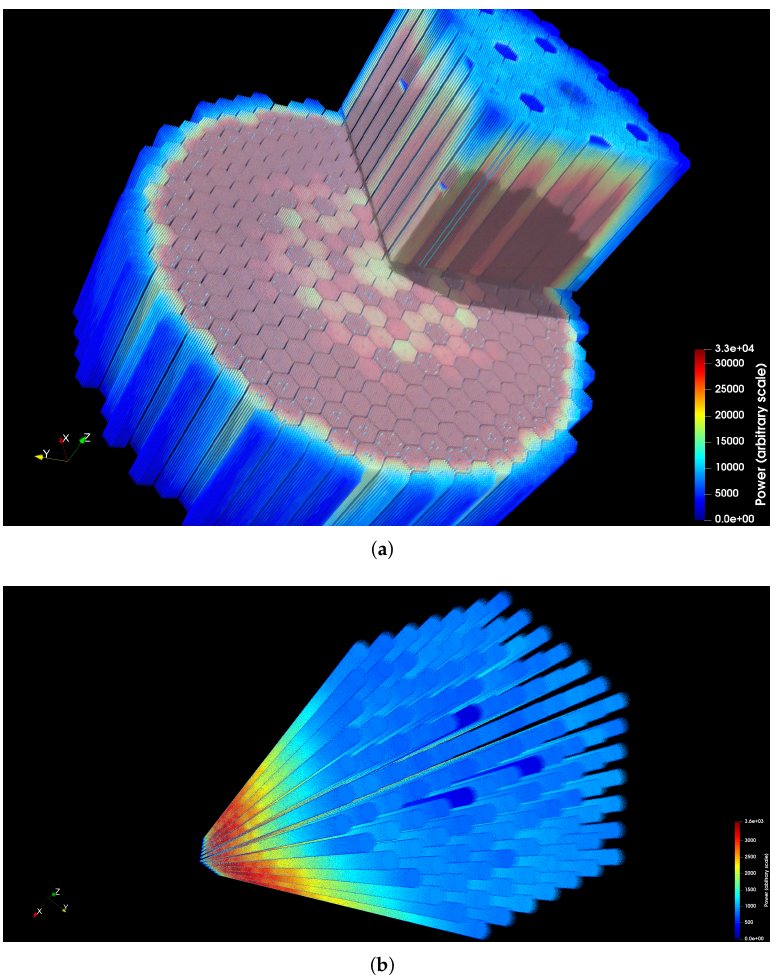
Figure 7. ( a ) Static power distribution for the whole core ( b ) and for a single assembly of type Gd-2n containing three pins filled with 3.35% Gd 2 O 3 burnable poison at HZP, with approx power of 1.5